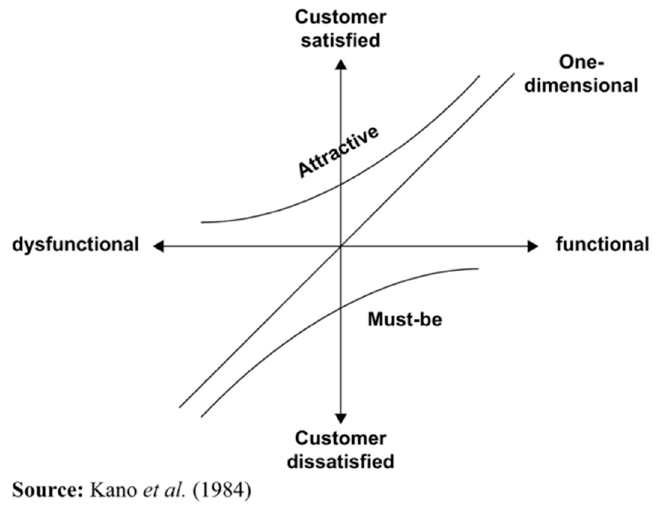
Figure 3. The framework of the Kano model. Table 4. Kano model functional and dysfunctional question sample.